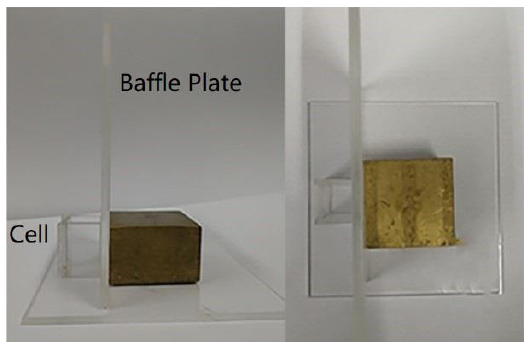
Figure 5. The experimental device for measuring the angle of repose.